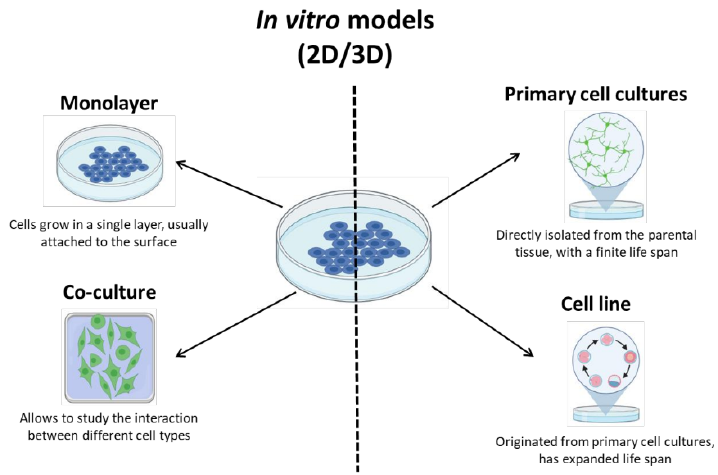
Figure 3. Culture of brain cells for 2D and 3D in vitro models.